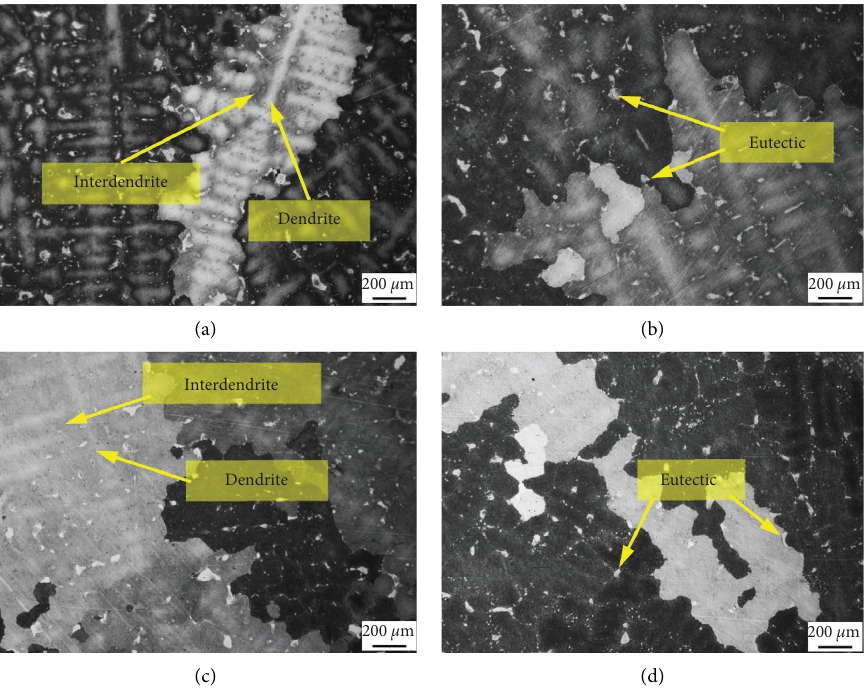
Figure 5: Dendrite morphology of the K417G alloy under as-cast (a), HIP1170 (b), HIP1185 (c), and HIP1195